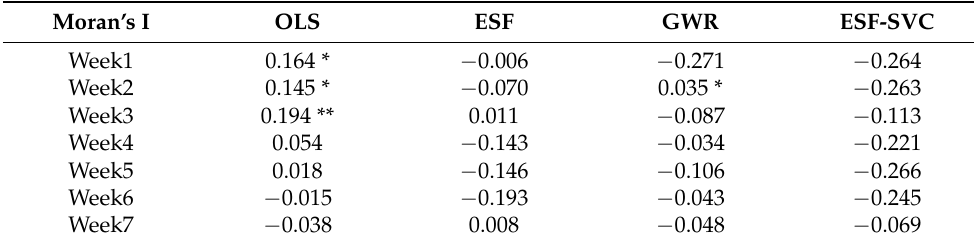
Table 6. Moran’s I values for model residuals in Hubei